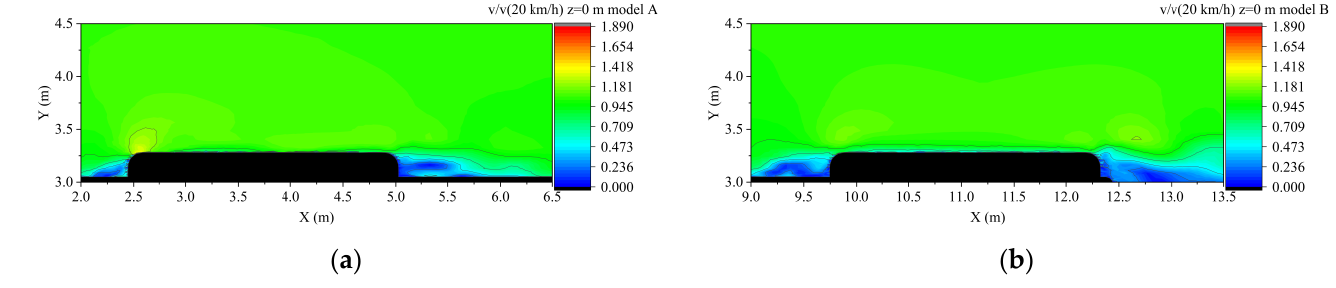
Figure 6. Longitudinal midsection velocity distribution around the AC unit for ( a ) model A; ( b ) model B.